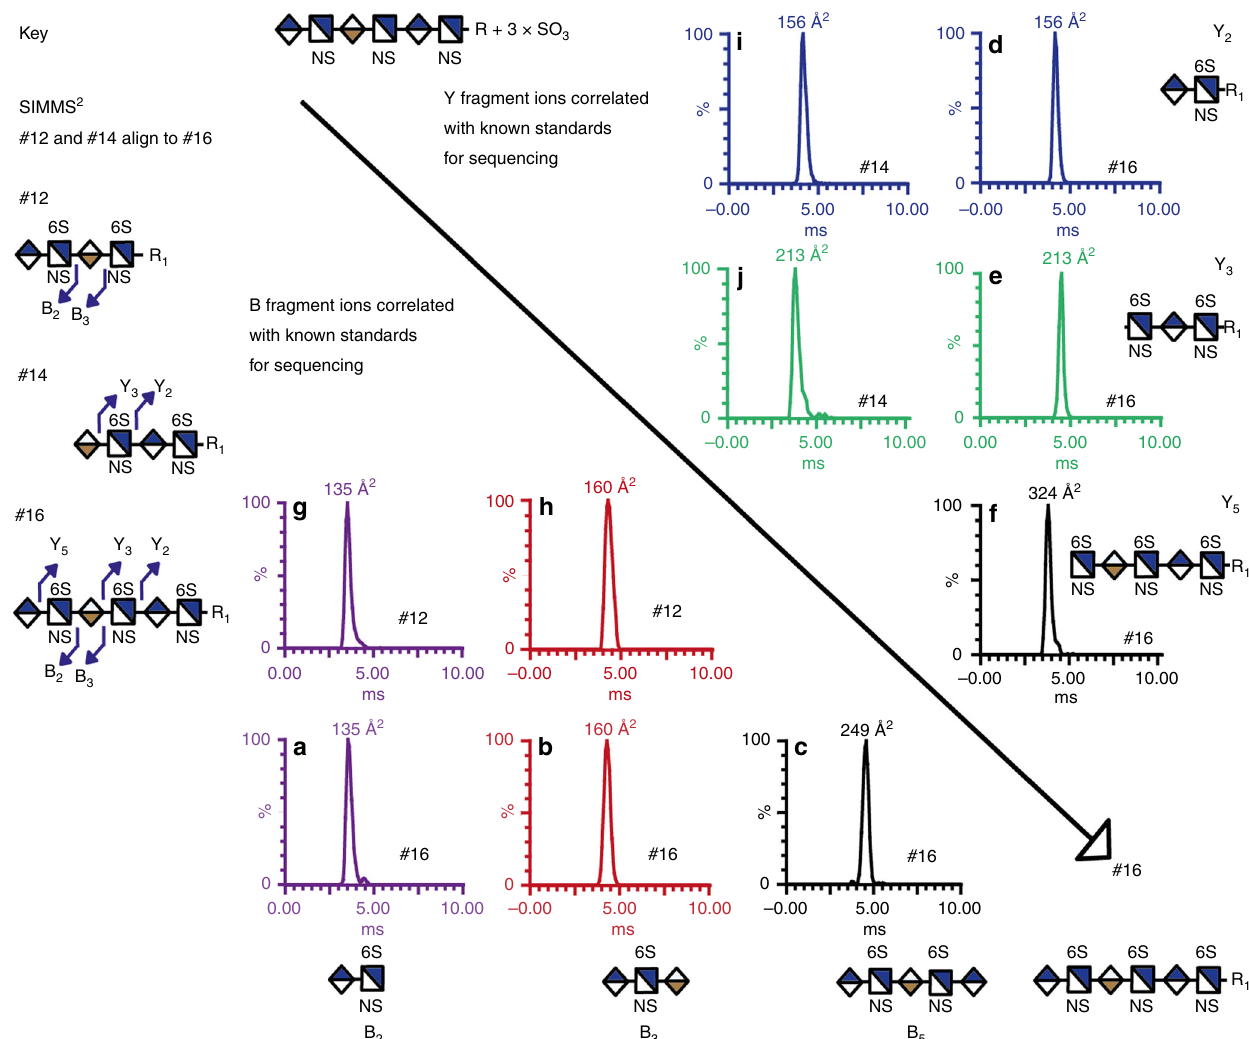
Fig. 3 Using the SIMMS 2 method for sequencing a hexasaccharide. Overlaying two tetrasaccharide standard structures ( #12 and #14 ) provides complete sequence coverage of the hexasaccharide ( #16 ). Each structure was fragmented in the trap of the mass spectrometer and analyzed using drift tube ion mobility mass spectrometry (DTIMS), resulting in accurate collision cross section (CCS) values. A comparison of overlapping fragment ions displayed the same CCS value between the two tetra- and hexasaccharides, providing a three-dimensional (MS, MS/MS and IMMS) sequencing method. a – f The hexasaccharide displays the DTIMS data to be determined. g , h Tetrasaccharide #12 displayed CCS values from B ions; B 2 — 135 Å 2 and B 3 — 160 Å 2 matched CCS values observed in the hexasaccharide ( a – c ). i , j Tetrasaccharide #14 displayed CCS values from Y ions; Y 2 156 Å 2 and Y 3 213 Å 2 matched the CCS values observed in the hexasaccharide ( d – f